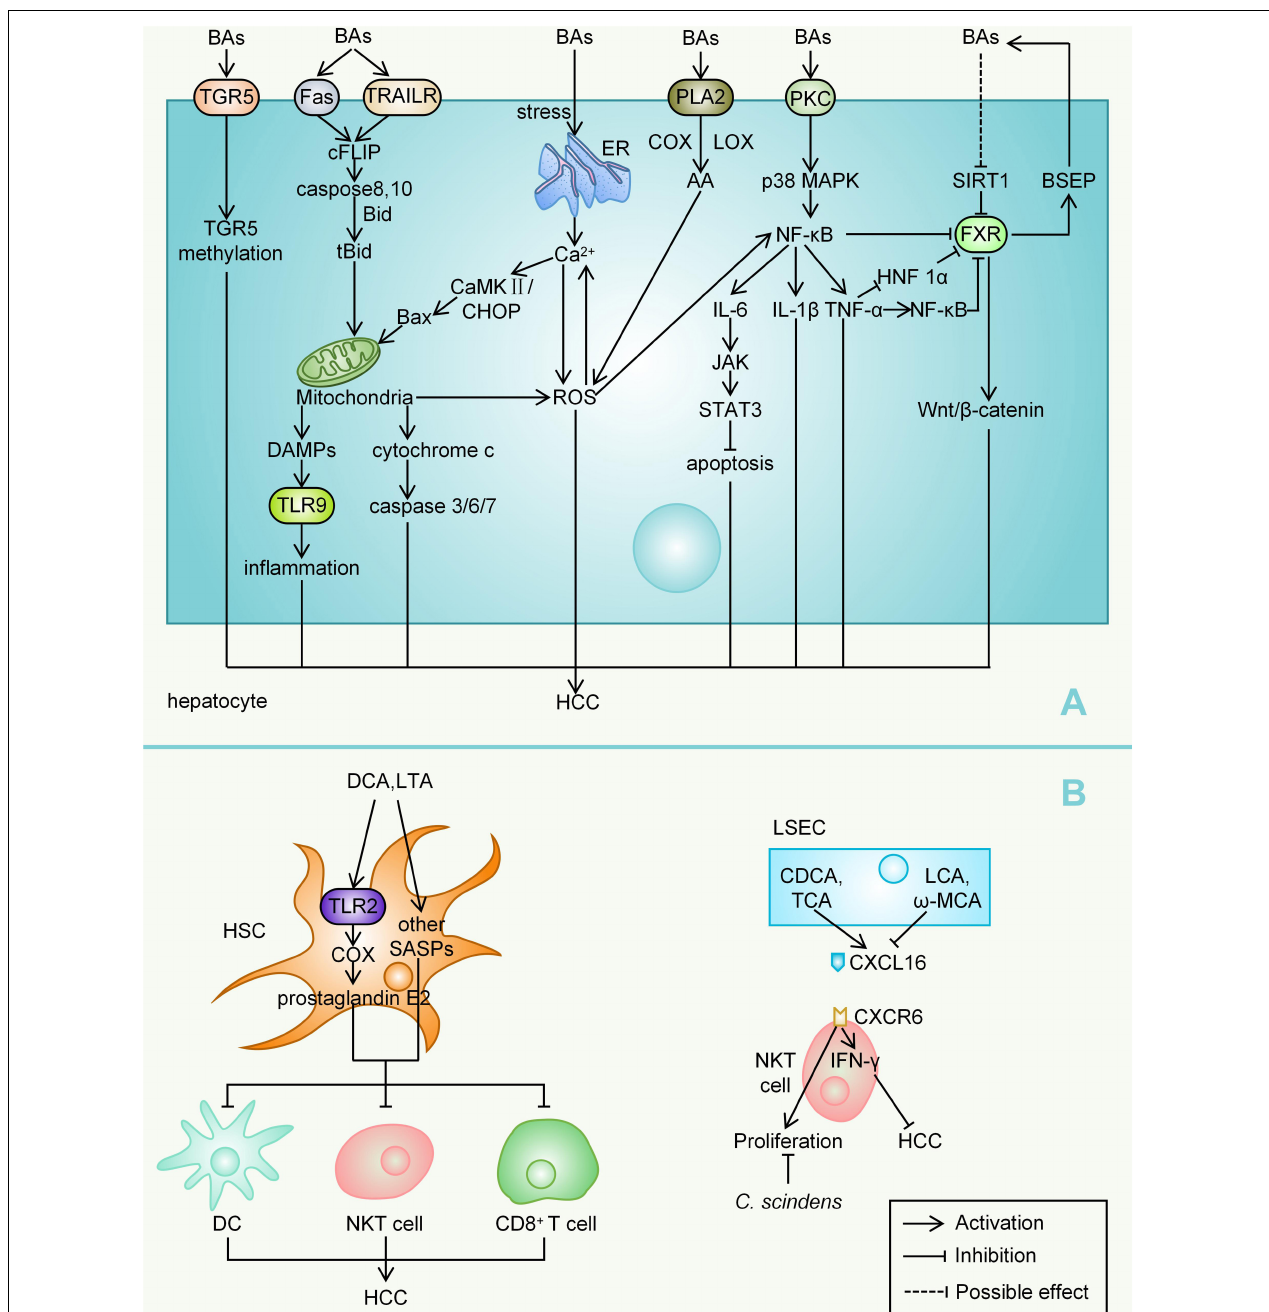
FIGURE 2 | Mechanisms by which BAs mediate HCC. (A) Bile acids, as important metabolites of the gut microbiota, can cause inflammatory responses, cell death, ROS accumulation, reduction of apoptosis, and so on, mainly by mediating complex signalling pathways within hepatocytes, ultimately leading to the development of HCC. (B) BAs can also act on other liver cells such as HSC, LSEC, NKT cell, and so on, thereby affecting HCC progression. BAs, bile acids; TRAILR, TNF-related apoptosis inducing ligand receptor; cFLIP, Cellular FLICE-like inhibitory protein; mtDNA, mitochondrial DNA; Bcl-2, B cell lymphoma-2; ROS, reactive oxygen species; TLR, Toll-like receptor; ER, endoplasmic reticulum; CaMKII, calcium/calmodulin-dependent protein kinase II; CHOP, C/EBP homologous protein; PKC, protein kinase C; MAPK, mitogen-activated protein kinase; JAK, Janus kinase; STAT3, signal transducer and activator of transcription 3; PLA2, phospholipase A2; AA, arachidonic acid; COX, cyclooxygenase; LOX, lipoxygenase; CDCA, chenodeoxycholic acid; DCA, deoxycholic acid; Egr-1, early growth response gene 1; EGFR, epidermal growth factor receptor; vcm-1, vascular endothelial cell adhesion molecule 1; FXR, Farnesoid X receptor; TDCA, taurodeoxycholic acid; TCA, taurocholic acid; SIRT1, sirtuin 1; FasL, fas ligand; HNF 1 α , hepatocyte nuclear factor 1 α ; TGR5, Takeda G protein-coupled receptor 5; HSC, hepatic stellate cell; LTA, lipoteichoic acid; SASP, senescence-associated secretory phenotype; DCs, dendritic cells; NKT cell, natural killer T cell; CXCR, C-X-C chemokine receptor type; LSEC, liver sinusoidal endothelial cell; LCA, lithocholic acid; ω -MCA, ω -muricholic acid; NK cell, natural killer cell.